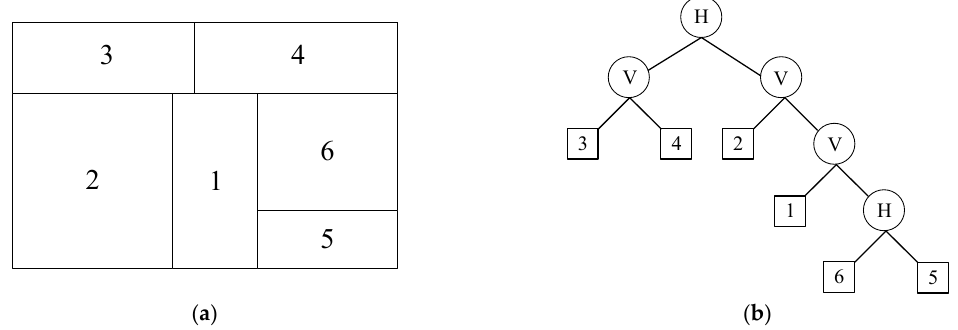
Figure 4. An example of the slicing tree structure. ( a ) Layout representation; ( b ) Tree structure.